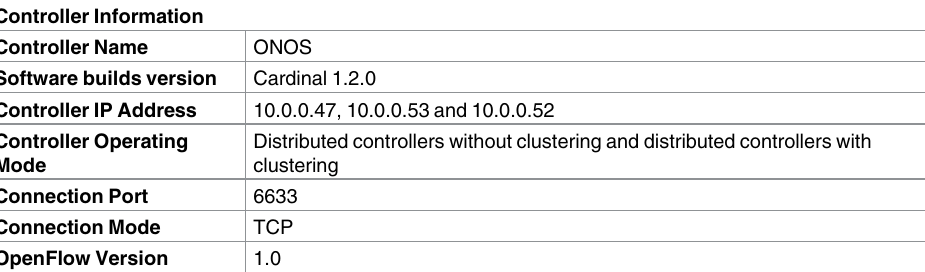
Table 2. ONOS controller